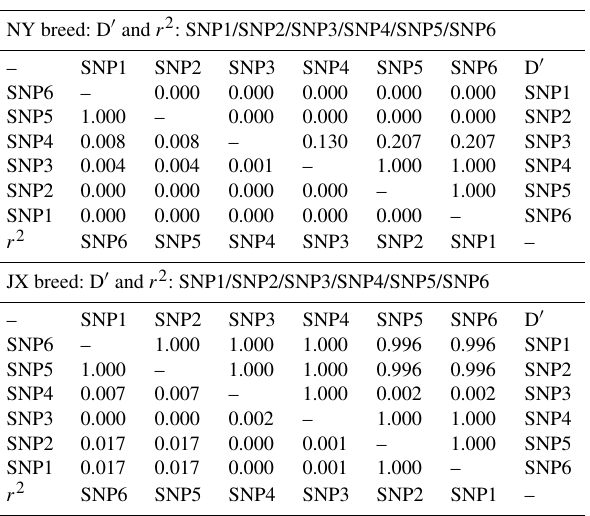
Table 5. Linkage disequilibrium tests for Nanyang cattle and Jiax- ian cattle.